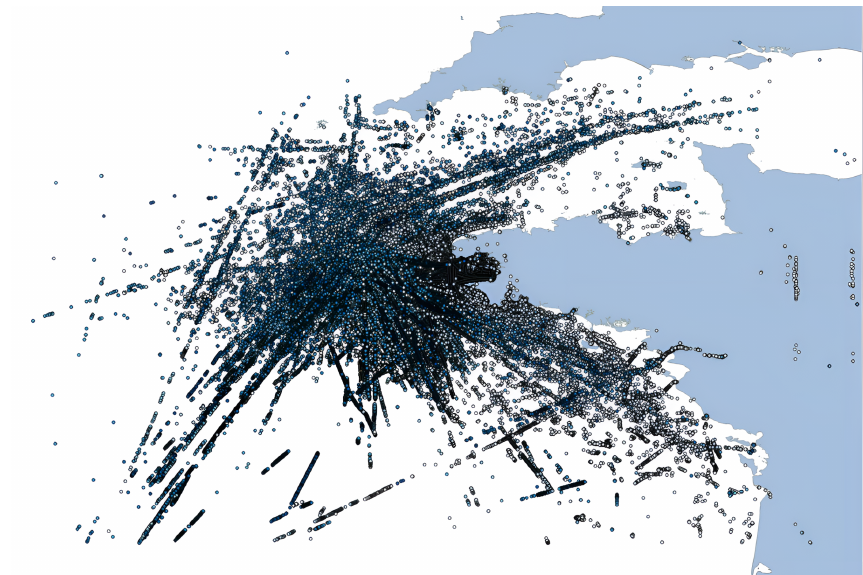
Figure 2. Vessel positions of the Brest, France dataset.